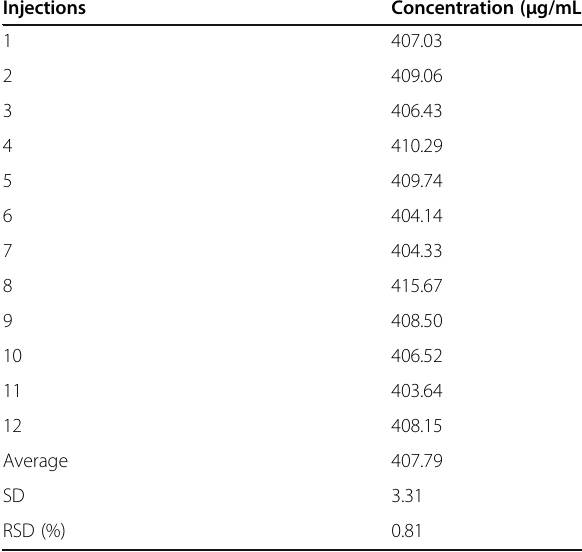
Table 6 Results of between batch precision study